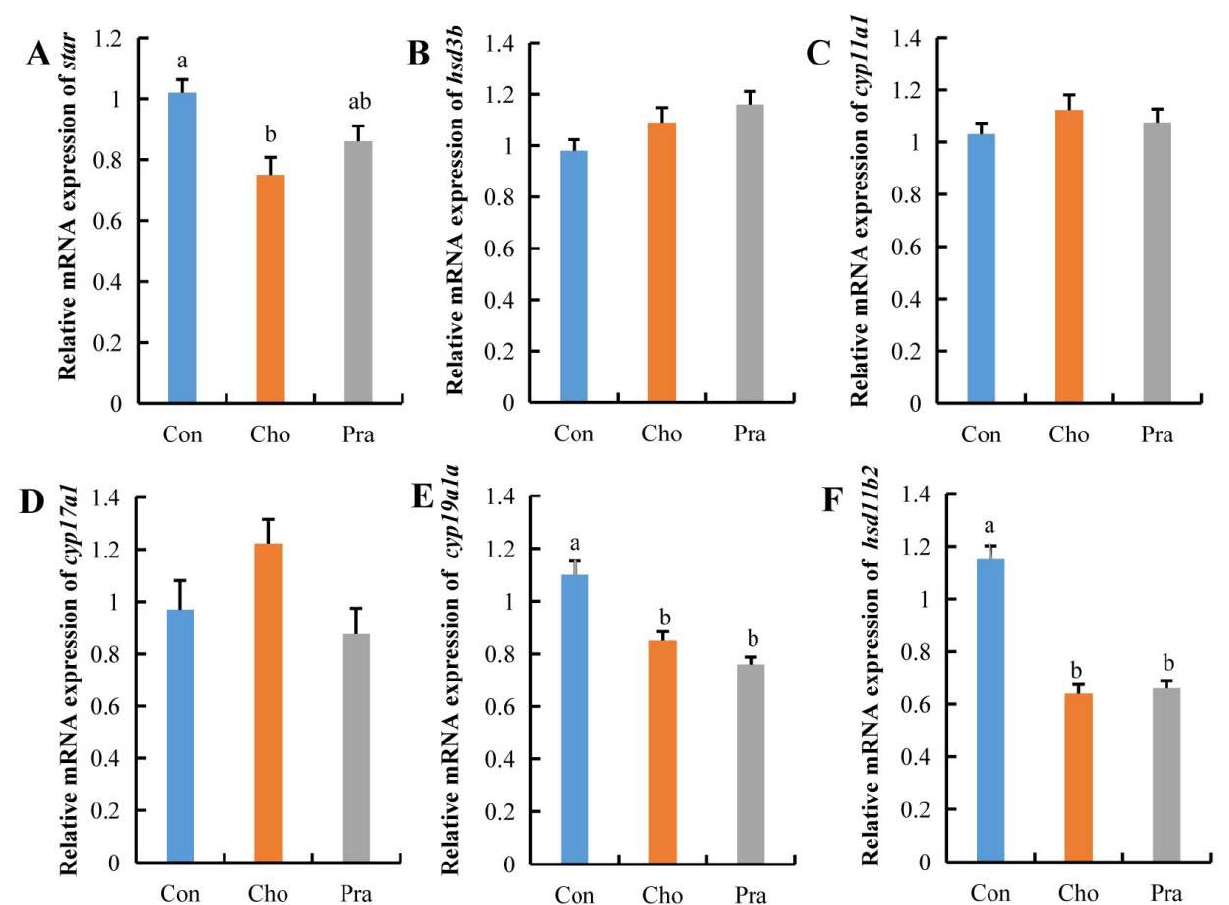
Figure 4. Changes in gene expression related to sex hormone synthesis. All statistical data were expressed as mean ± SD. ( A – F ) represents the relative mRNA expression of star , hsd3b , cyp11a1 , cyp17a1 , cyp19a1a , and hsd11b2 genes, respectively. There is a significant difference between the two groups without the same letter at p < 0.05 level.